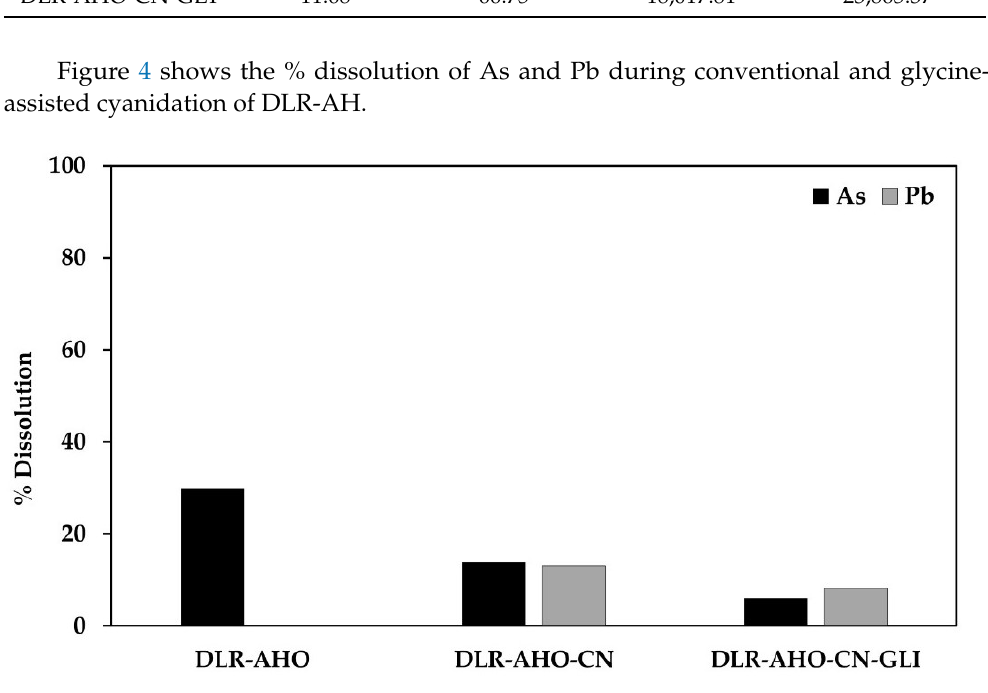
Figure 4. % Dissolution of As and Pb during conventional and glycine-assisted cyanidation of DLR-AHO.